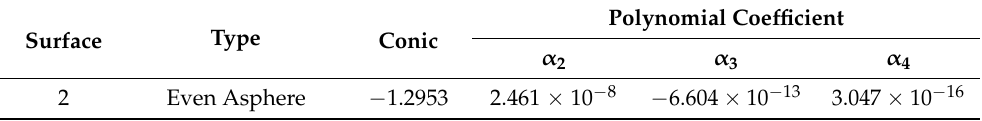
Table 4. Lens data detail of aspheric